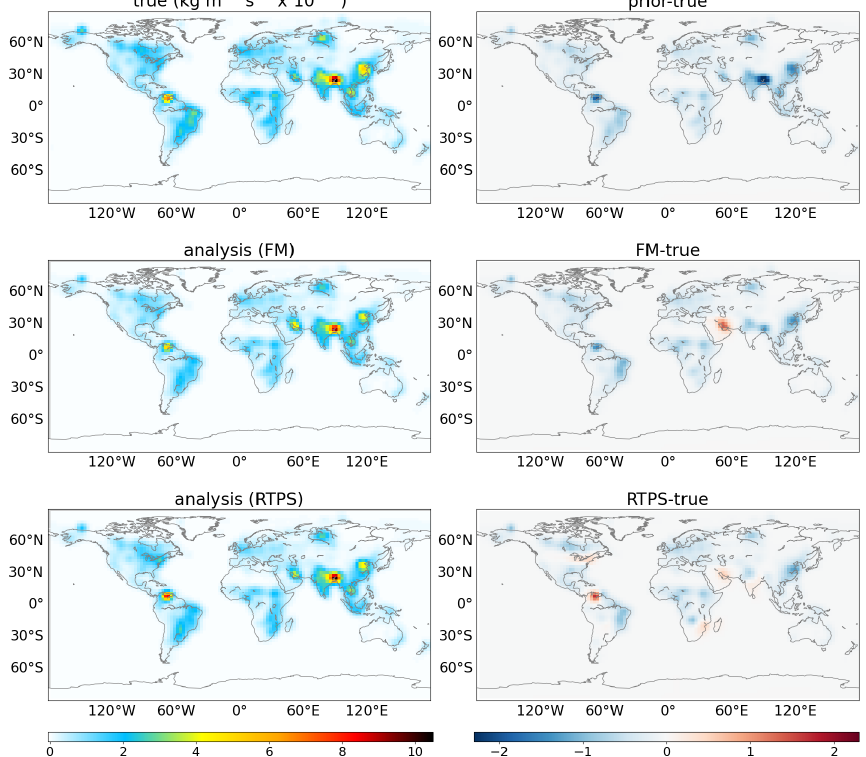
Figure 10. Same as Fig. 9 but for